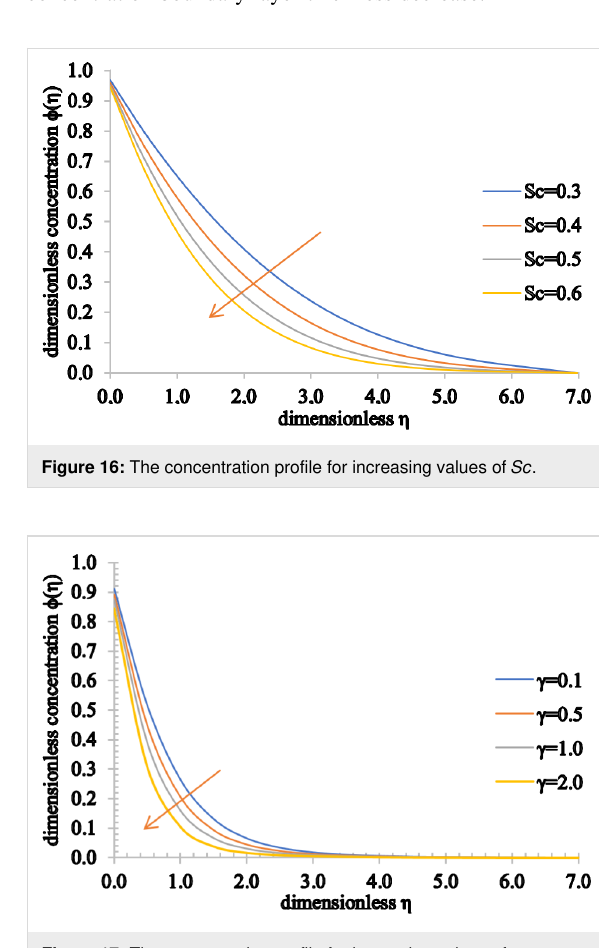
Figure 18 and Figure 19 show the influence of the ther- mophoresis parameter on the temperature and concentration dis-